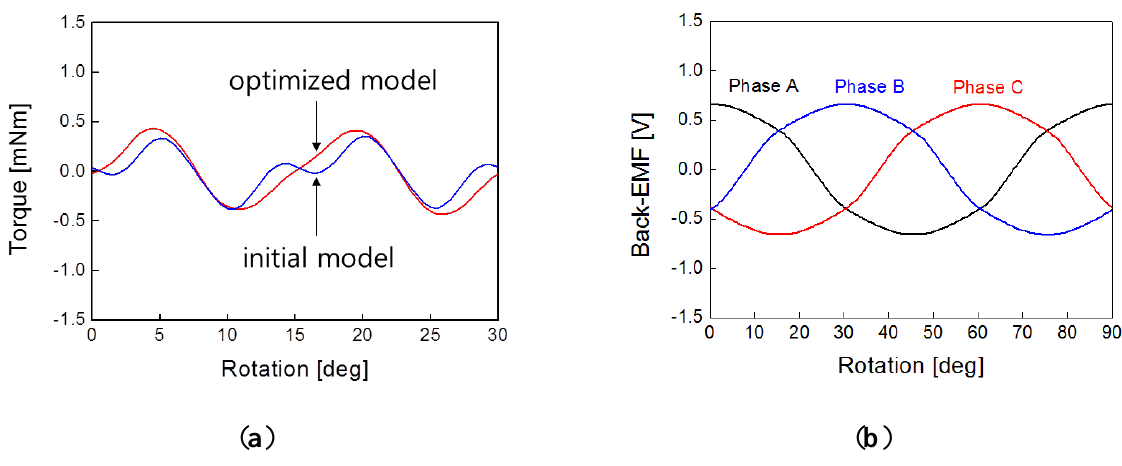
Figure 7. Simulation results of the optimized model: ( a ) cogging torque and ( b ) back-EMF (720